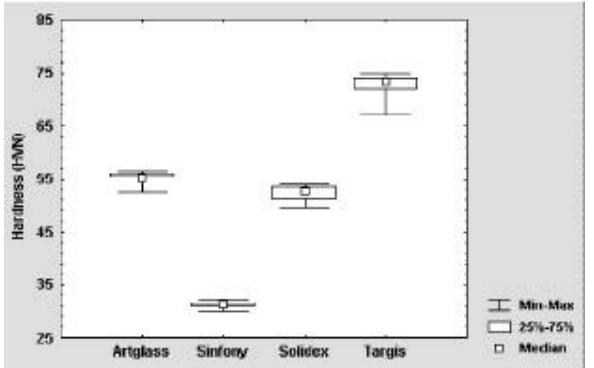
FIGURE 2 - Mean microhardness values (HVN) and standard deviation for each tested material